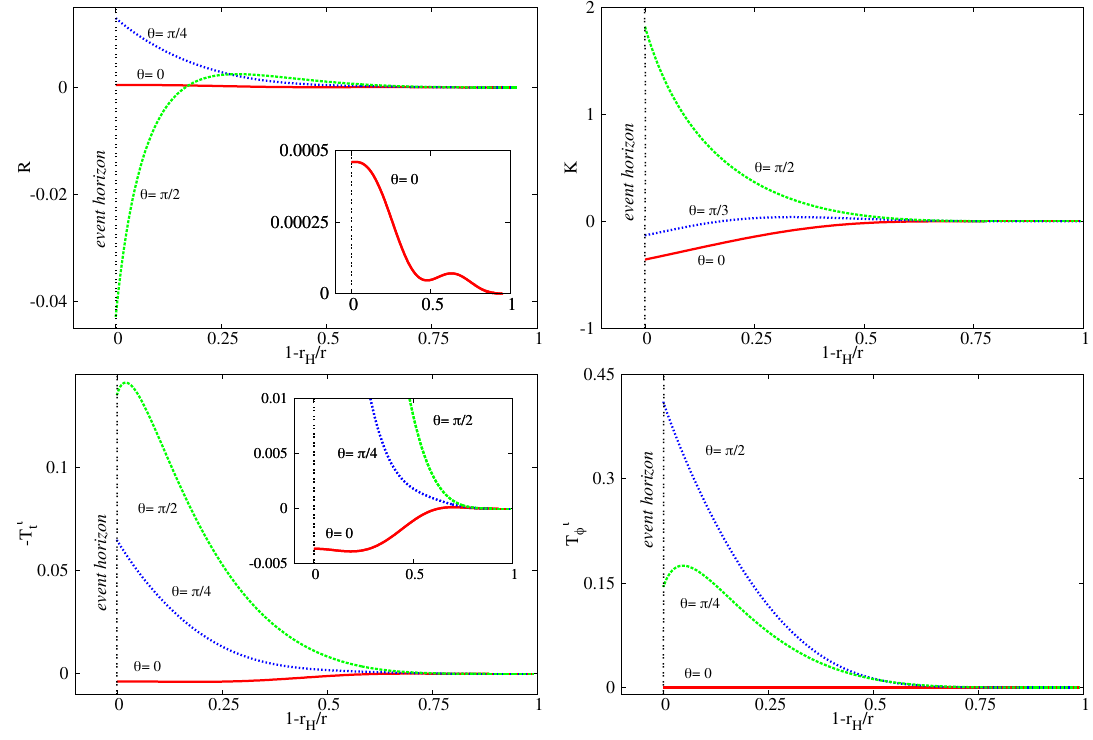
Figure 2 . The Ricci R and Kretschmann K scalars and the components T t energy-momentum tensor, vs. 1 (cid:0) r H =r , for three di(cid:11)erent polar angles (cid:18) and the same solution as in (cid:12)gure 1. The inset of the bottom left panel shows the existence of a region of negative energy densities around the axis. The inset of the top left panel shows a zoom of the (cid:18) = 0